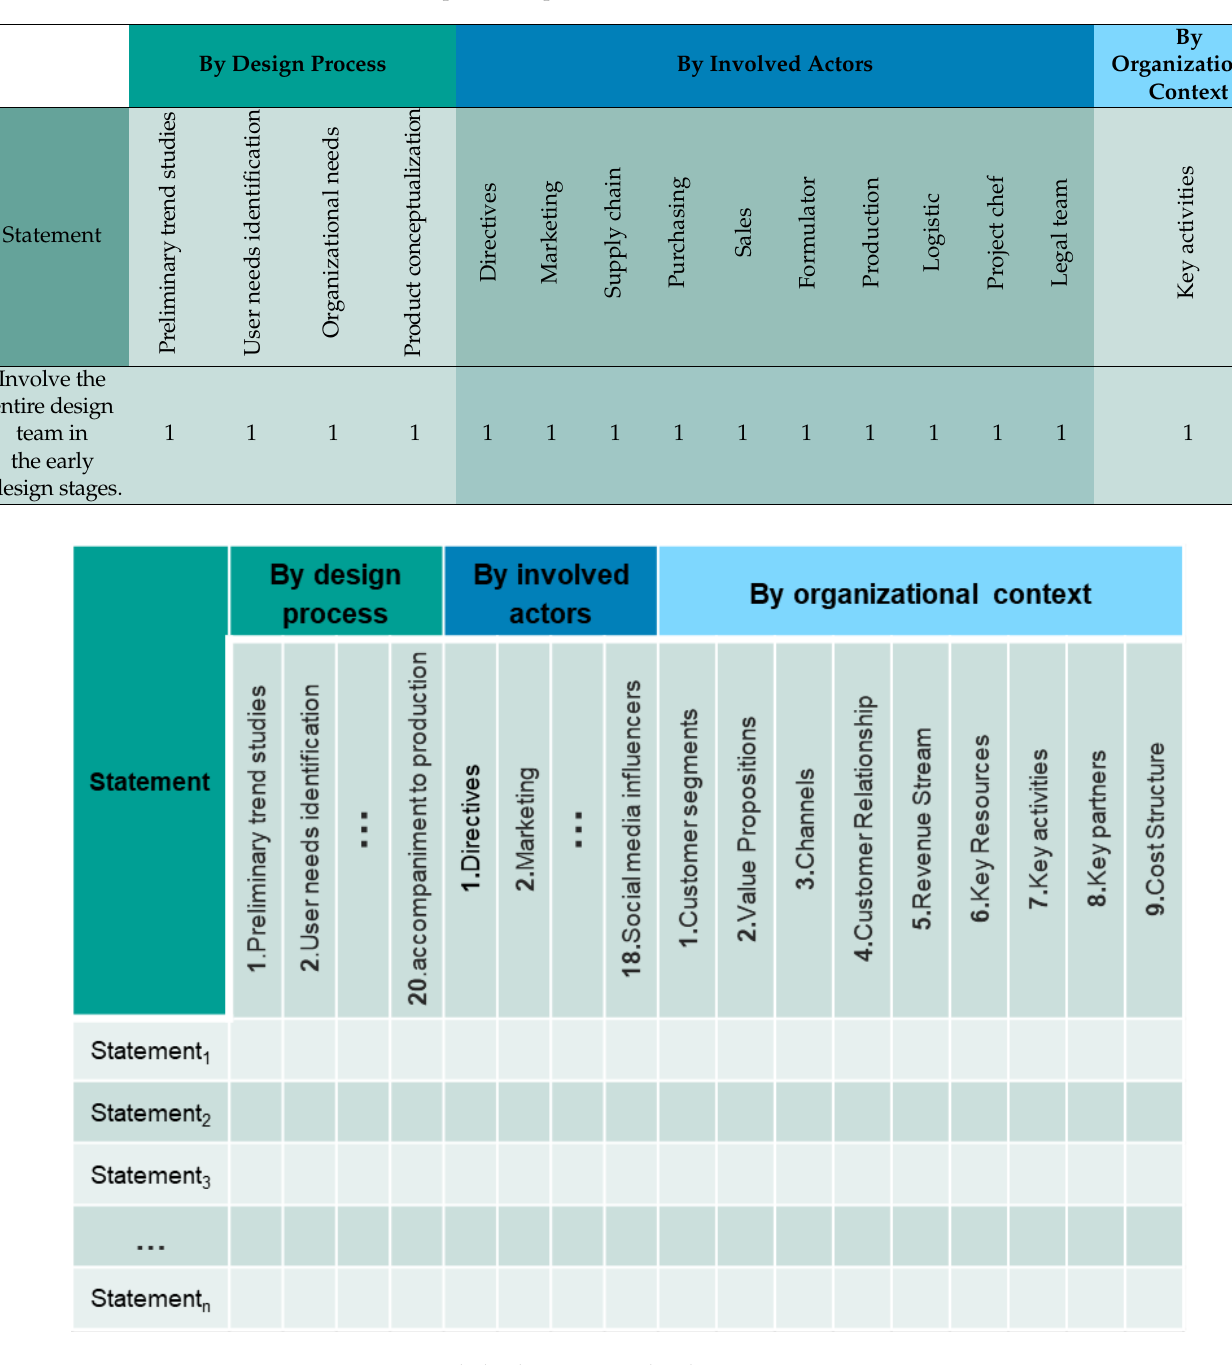
Figure 9. Knowledge base matrix sketch. Figure 8. Knowledge base matrix